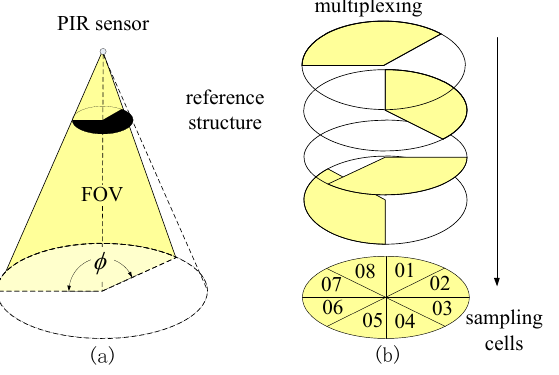
Figure 3. Type I mask: ( a ) bearing segmentation; ( b ) multiplexing of four PIRs forms eight sampling cells. FOV: field of view. Table 1. The coding scheme of angle θ